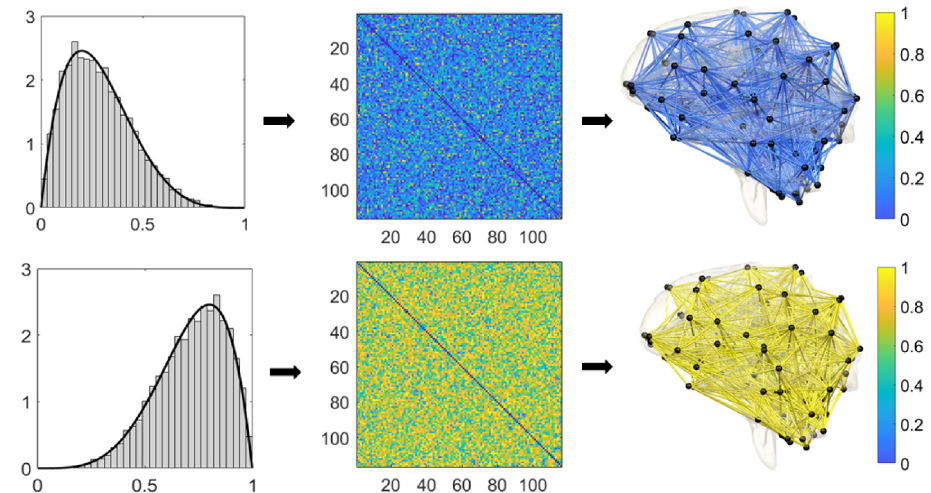
Fig 2. Visualization of simulated brain networks with 116 nodes. Left: The empirical density functions of simulated edge weights from Beta(2, 5) (top) and Beta(5, 2) (bottom) distributions. Middle: The 116 × 116 correlation matrices constructed using the simulated edge weights. Right: Human brain networks with the simulated edge weights. Since correlation networks are too dense for visualization, we only displayed edges with values below 0.1 and above 0.9.